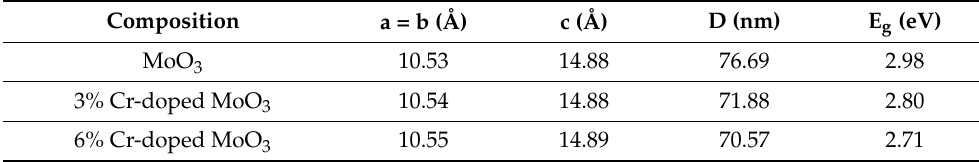
Table 3. Data on structural and physical parameters of un-doped and Cr-doped MoO 3 microrods.